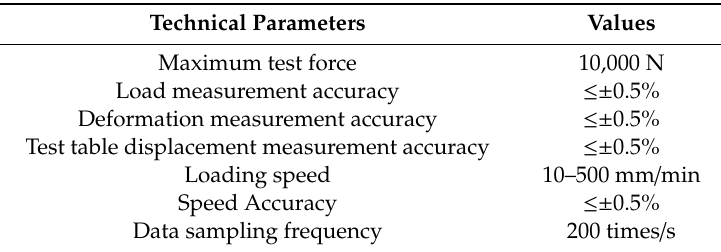
Table 4. Technical parameters and accuracy of the MTS testing